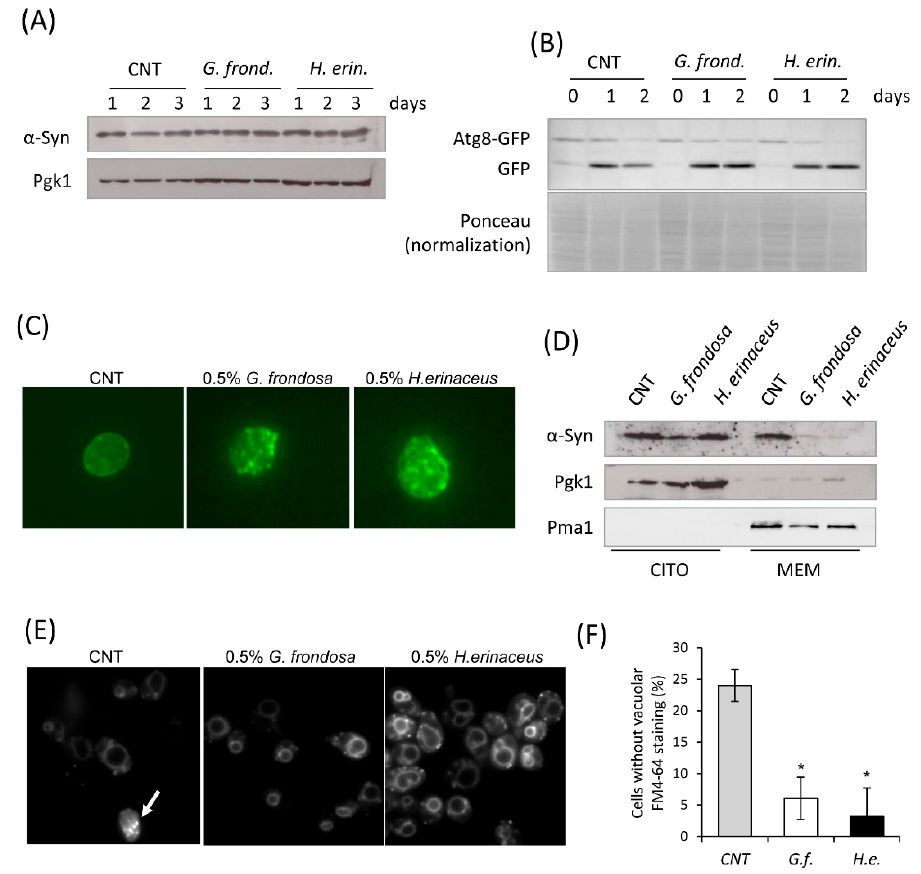
Figure 6. Fungal extracts induce α -synuclein delocalization. ( A ) Western analysis using anti- α -synuclein antibody on total extracts from wt[ α Syn] cells after 24 h treatment with 0.5% fungal extract. Pgk1 was used as loading control. ( B ) Western analysis using anti-GFP antibody on total extracts from wt[ α Syn][Atg8-GFP] cells treated with 0.5% fungal extract. PonceauS staining was used as loading control. ( C ) Immunofluorescence showing localization of α -synuclein in cells untreated or treated for 1 day with 0.5% fungal extracts. ( D ) Western analysis using anti- α -synuclein antibody on cytoplasmic and membrane fractions isolated from wt[ α Syn] cells after 24 h treatment with 0.5% fungi extract. Pgk1 was used as cytoplasmic marker, Pma1 as membrane marker. ( E , F ) wt[ α Syn] cells were grown in exponential phase in the presence or absence of 0.5% extract of G. frondosa or H. erinaceus and stained for 15 min with FM4-64, as reported in materials and methods. Cells with or without FM4-64 staining at the vacuolar membrane were counted at the microscope, mean ± standard deviations are shown. * p < 0.05 relative to control condition (no extract).